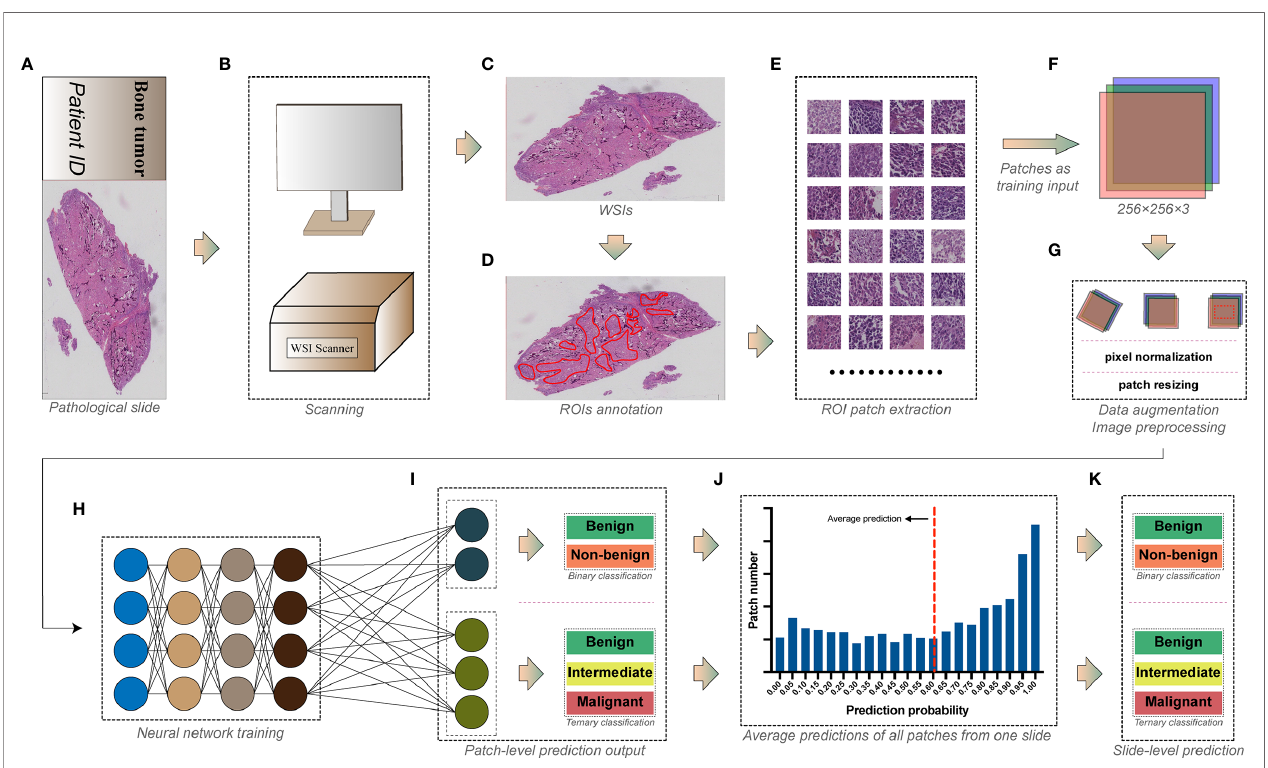
FIGURE 1 | The work fl ow for deep learning training. (A) The pathological slide prepared from bone tumor specimens. (B) Whole slide imaging (WSI) scanning. (C) Whole slide images with ultra-high resolution. (D) Tumor areas annotated by pathologists as regions of interest (ROIs). (E) Regions of interest were exported as numerous square image patches of the same size. (F) Three-channel RGB image patches of 256 × 256 pixels were used as training input. (G) Data augmentation and image preprocessing before training. (H) Image patches in the training dataset were fed into the convolutional neural network for training. (I) Models were trained for the patch-level binary and ternary classi fi cation. (J) Predictions of all patches from one slide were averaged to obtain (K) the slide-level binary and ternary